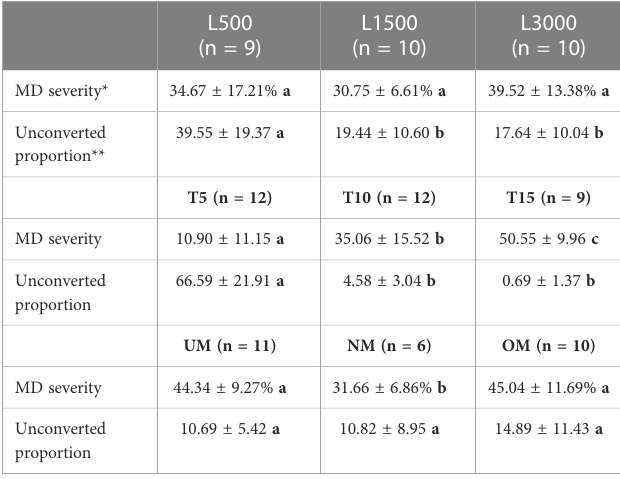
TABLE 2 Malformation severity for different treatment